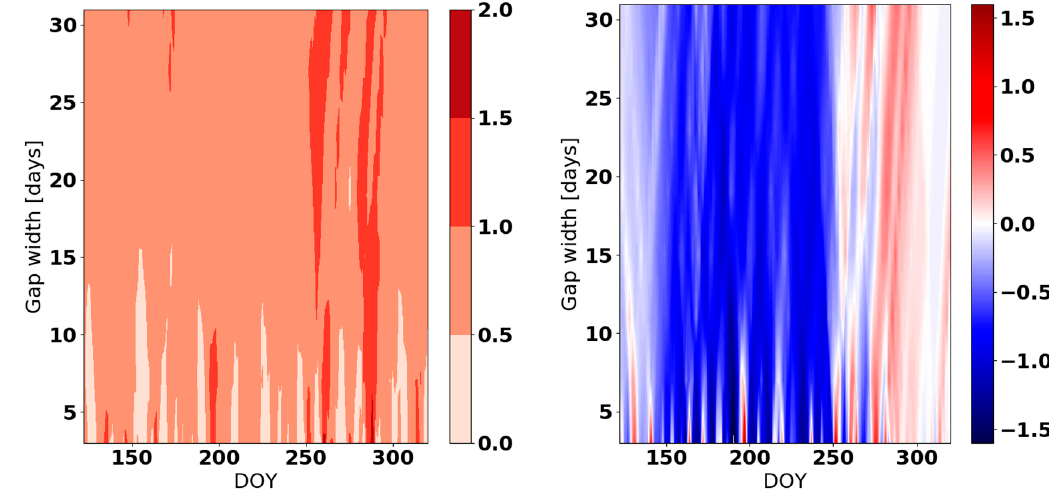
Figure A10. RMSE DEB ( left panel ) and (RMSE DEB -RMSE ERA5 ) difference ( right panel ) calculated using daily data for DOY 122-320 2016 in Pianosa.